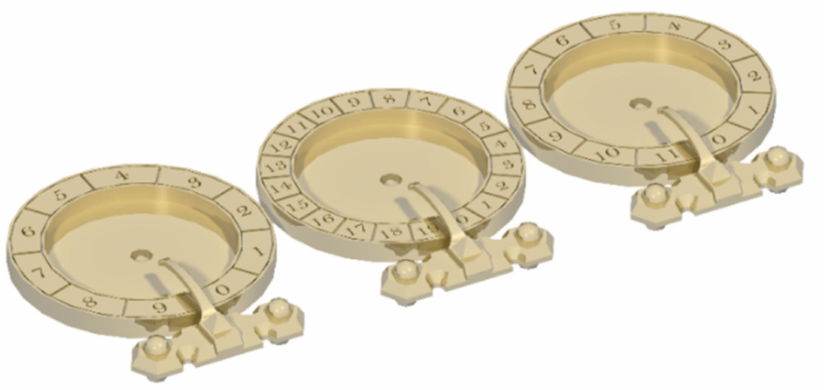
Figure 19. Models of the numbered crowns together with the stop bars in their real relative position.